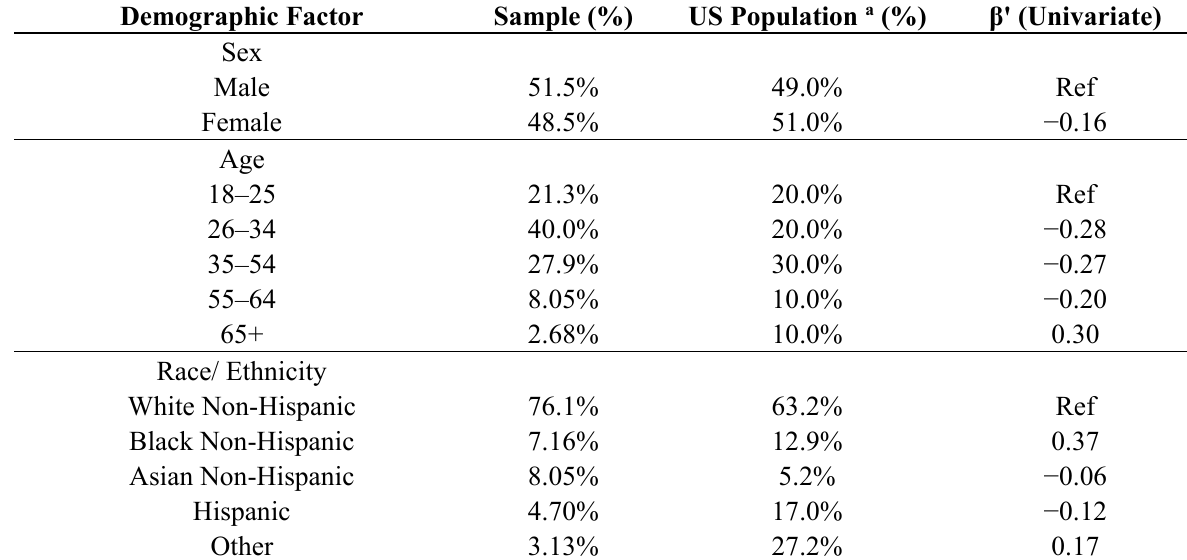
Table 2. Descriptive statistics of survey participants ( N = 447) and univariate regression relationship with system